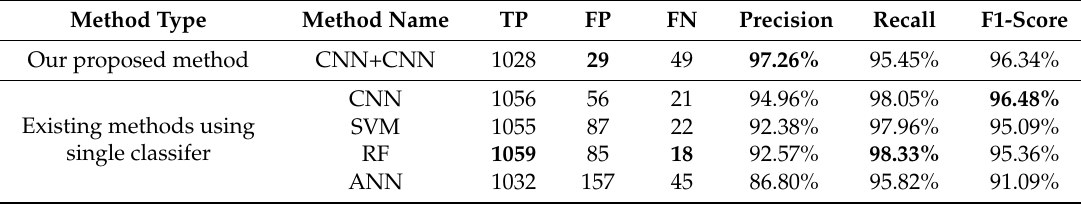
Table 8. The detection result of each method in Region